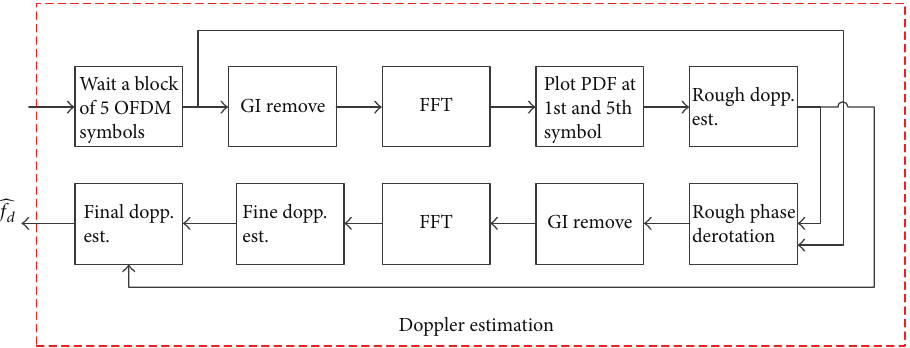
Figure 2: Proposed Doppler estimation.